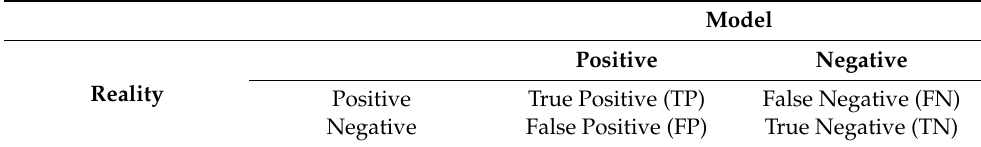
Table 1. Confusion matrix.